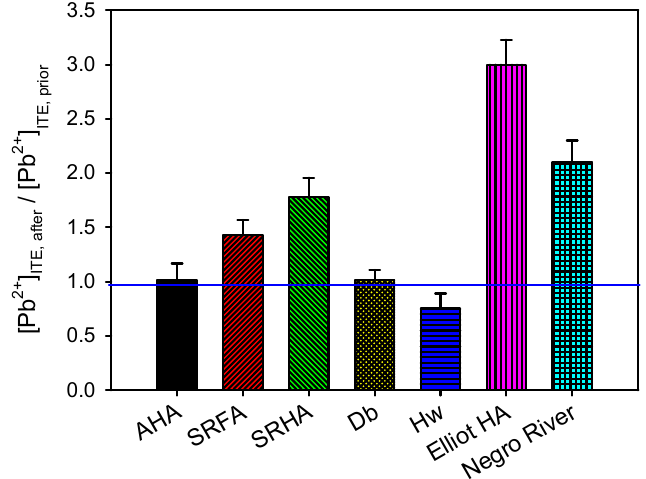
Figure 4. Effect of the DOM nature of Pb speciation in the presence of 10 mg L − 1 and irradiated at dose 3.2 × 10 5 J/m 2 . Error bars correspond to standard deviations of three replicates. Ion exchange speciation technique (IET) at “equilibrium mode” was used to determine the concentrations of the free lead ions, [Pb 2+ ] in the presence of DOM. The values were normalized to IET measured Pb concentration in non-irradiated DOM [Pb] ITE,prior . AHA: Aldrich humic acid, SRFA: Suwannee River fulvic acid and SRHA: Suwannee River humic acid [41]; Db: organic matter from Duebendorf WWTP effluent, Hw: organic matter from Hinwil WWTP effluent [56,57], Elliot HA: Elliot humic acid, Negro River: Organic matter isolated form Negro River [58].